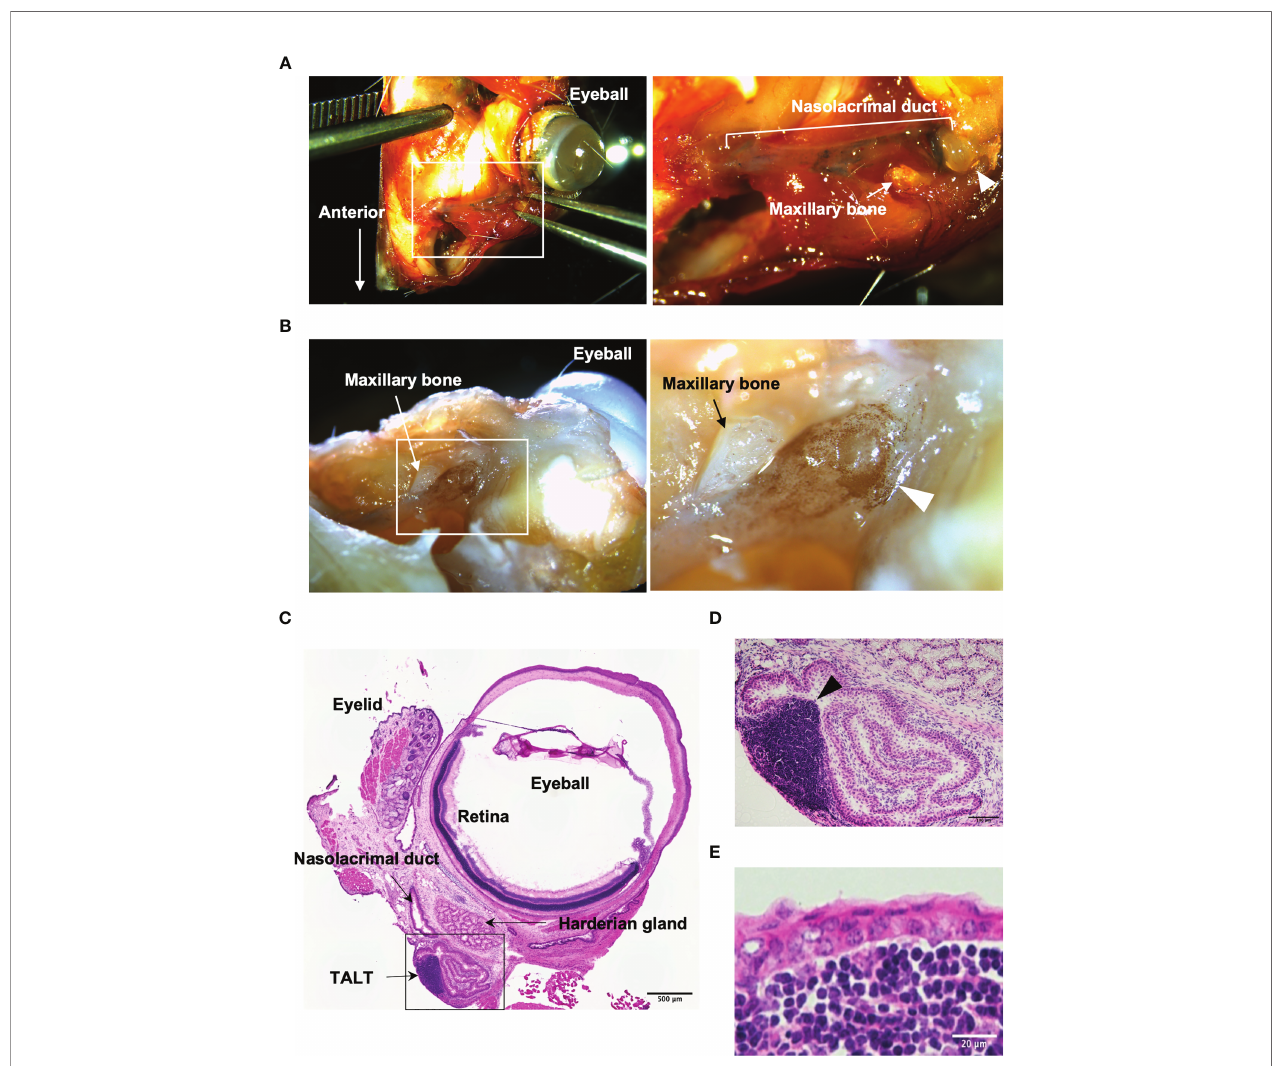
FIGURE 1 | Macroscopic isolation of TALT from mice head. (A) A stereomicroscopic image of the face around the eye of the mouse is shown. The nasolacrimal duct contains Evans blue that is a blue staining solution given via eye drops. The right panel shows the highly magni fi ed image of the area surrounded by the white line in the left panel. (B) A whole-mount immunohistochemical image of the same sample in panel (A) is shown. B lymphocytes were detected with HRP labeled anti-B220 antibody (brown). The right image is an enlarged view of the squared area in the left panel. Each arrowhead in panels (A, B) shows a lacrimal sac of the nasolacrimal duct. (C – E) Hematoxylin and eosin-stained sections of excised ocular mucosal tissue. Panel (D) shows a highly magni fi ed image of the lacrimal sac area surrounded by a black line in panel (C) An arrowhead indicates a lymphoid follicle of TALT. TALT is covered with strati fi ed squamous epithelium. n = at least 5 animals. Bars: 500 µm (C) , 100 µm (D) , 20 µm (E)